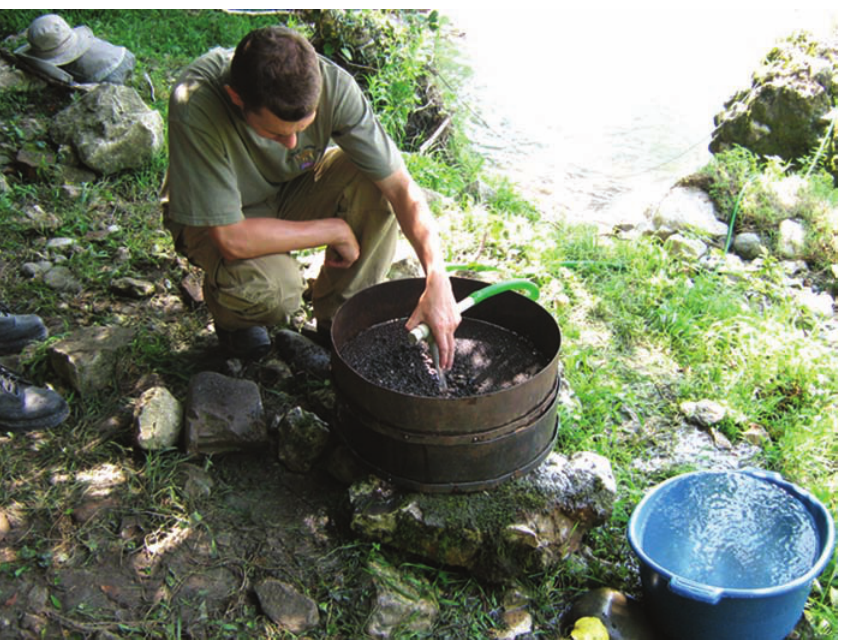
Figure 3 Bradford student, David Crowther, wet-sieving an environmental sample containing cremated remains